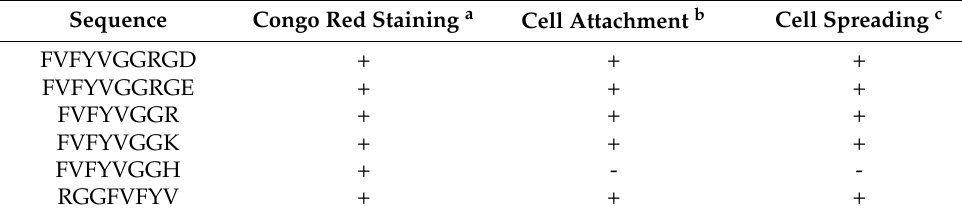
Table 3. Biological activities of modified FVFYV peptides.